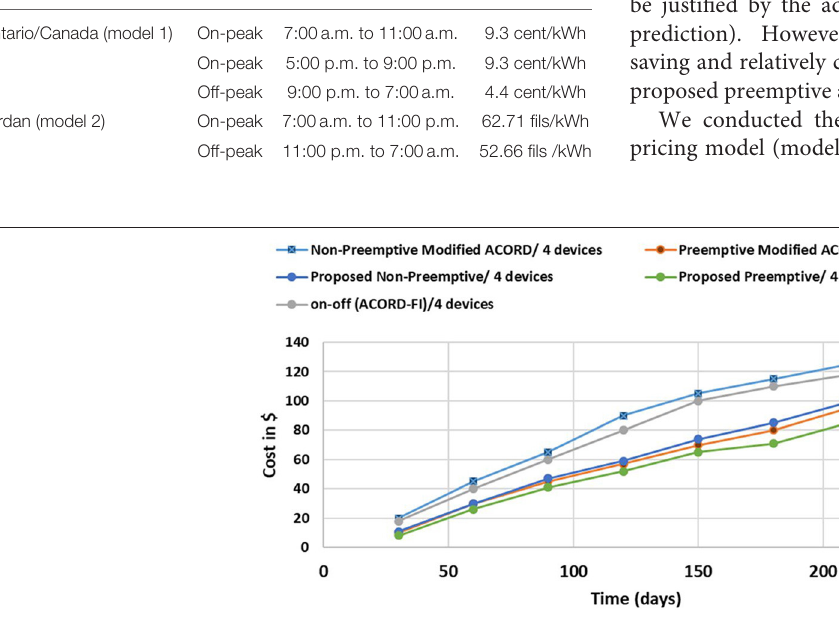
FIGURE 6 | Total energy cost of using 4 appliances with price model 1.